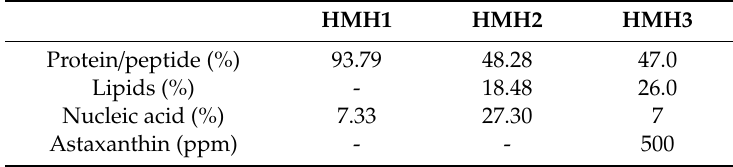
Table 1. Chemical composition of the herring milt hydrolysate (HMH)